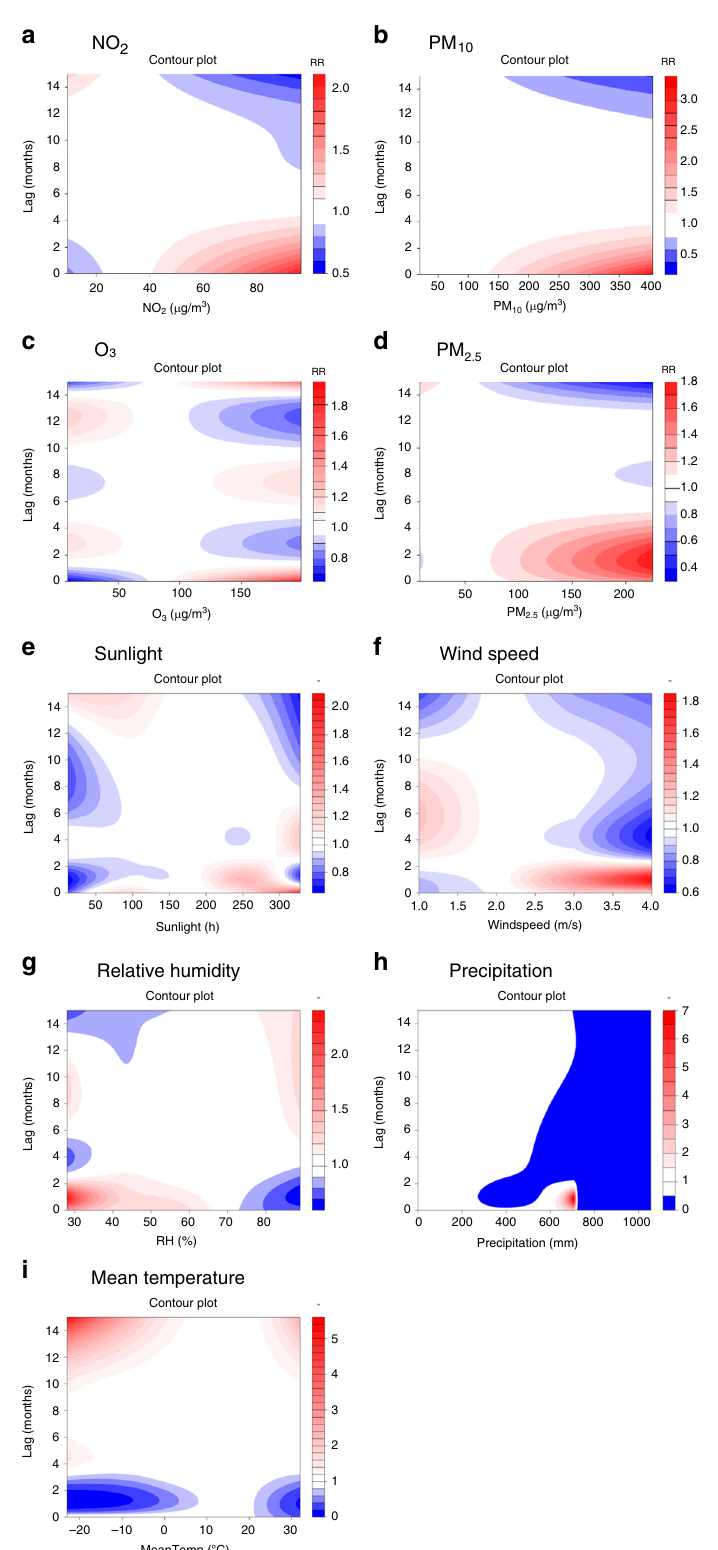
Fig. 5 Contour plots of the exposure – response relationship for the association between scarlet fever incidence and air pollutants or meteorological conditions in the single-variable model. a – d Four air pollutants from 2013 to 2018. e – i Five meteorological variables from 2004 to 2018. The reference level is set as the median value of the corresponding variable. In the single-variable model, we further adjust the temporal trend, as well as quantile groups both for average incidences and for incidence in the previous month. The Y -axis is the lag month ranging from 0 to 15. The X -axis is the range of the observed values of each variable. The color gradient represents the relative risk (RR). The red color gradient represents higher strength of RR, above 1, and the blue gradient represents lower strength of RR, below 1. The white color represents no difference, at RR = 1. Source data are provided as a Source Data fi